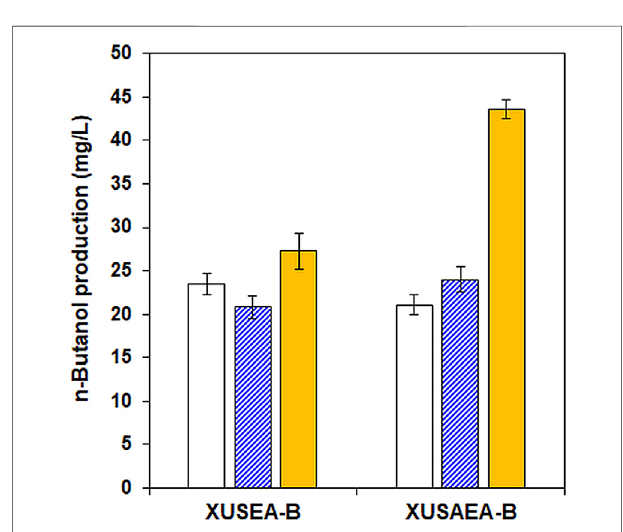
FIGURE5| Comparison ofn-butanolproduction bytheXUSEA-Bstrain and the acetate-tolerant strain of XUSAEA-B during glucose/xylose co- fermentation. Fermentation was conducted using an initial OD of 0.2 with 0 g/ L(solid,white)and1 g/L(pattern,blue)ofacetatesupplementationatpH 5.0. n-butanol production at pH 6.5 was also evaluated with 1 g/L of acetate supplementation (solid, yellow). The error bars represent standard deviations obtained using biological